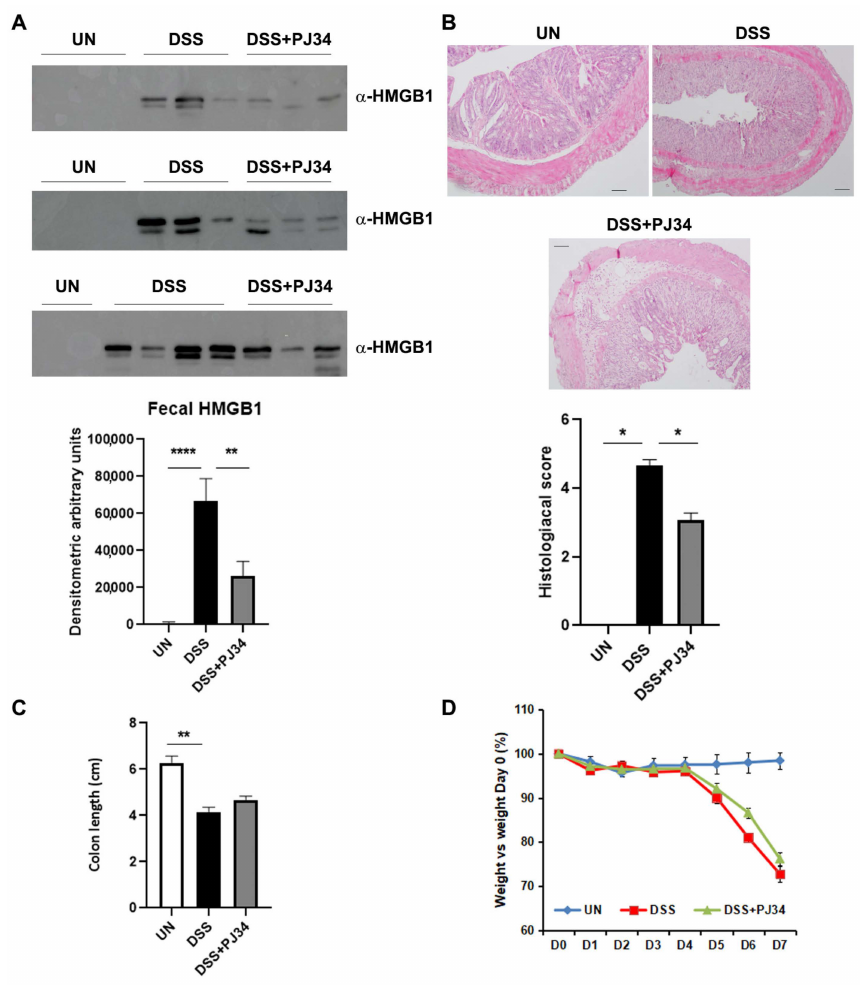
Figure 3. PARP1-inhibitor, PJ34, strongly reduces fecal HMGB1 in DSS-treated WT mice and improves the architecture of intestinal mucosa. WT mice were treated with 3% DSS (10 animals) or cotreated with DSS and 10 mg/kg of PARP1 inhibitor, PJ34 (9 animals). ( A ) Analysis of fecal HMGB1; ( B ) histol- ogy and histological score (Scale bar = 100 µ m); ( C ) animal weight; ( D ) animal colon length. Statistical analysis was performed using the Mann–Whitney U test. * p < 0.05; ** p < 0.01; **** p <